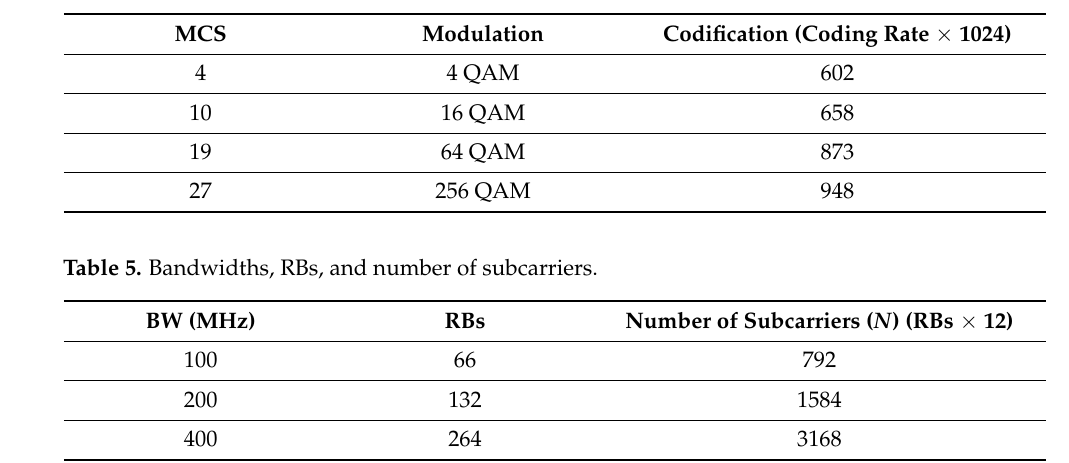
Table 4. Modulation and coding schemes (MCS).